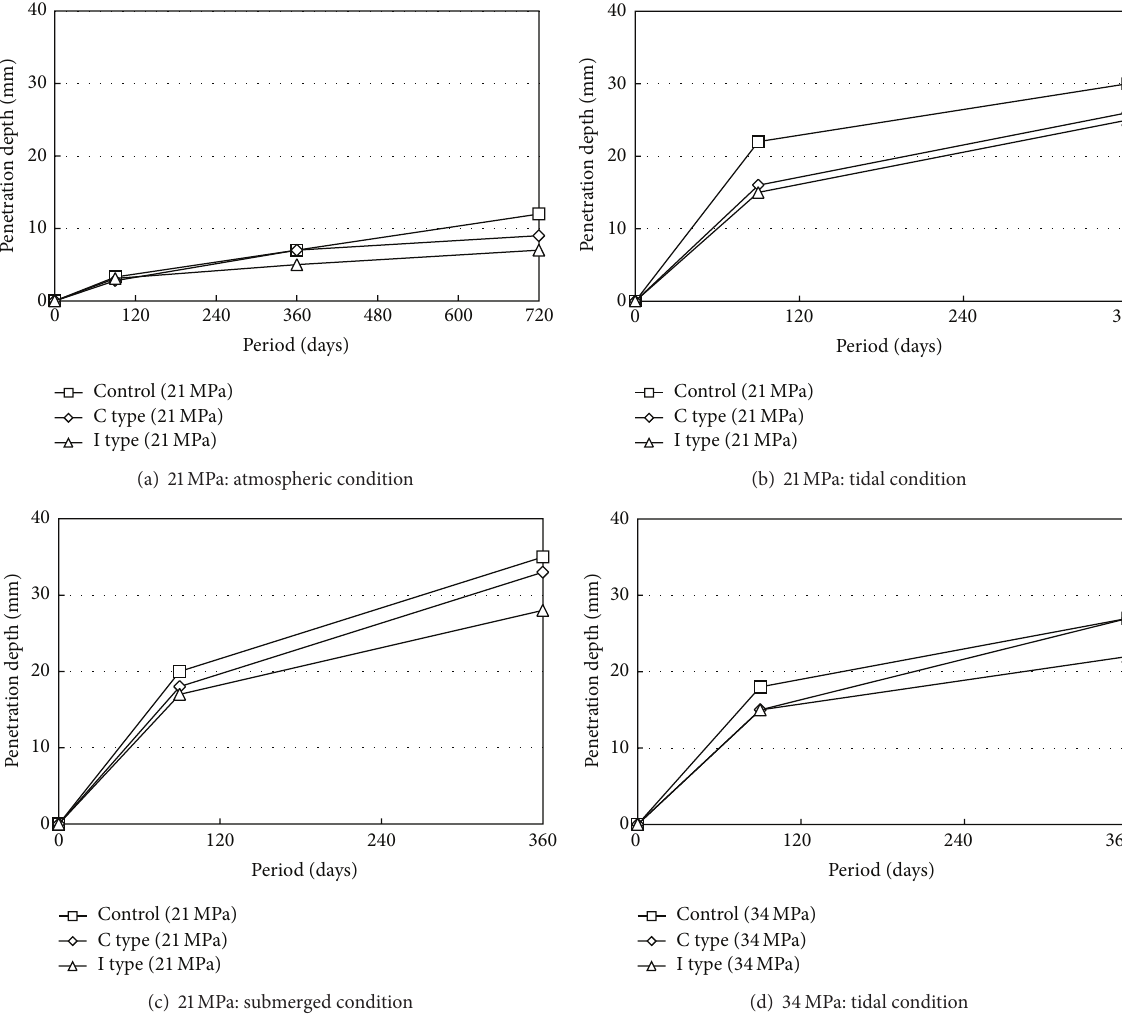
Figure 6: Chloride penetration depth in surface-impregnated